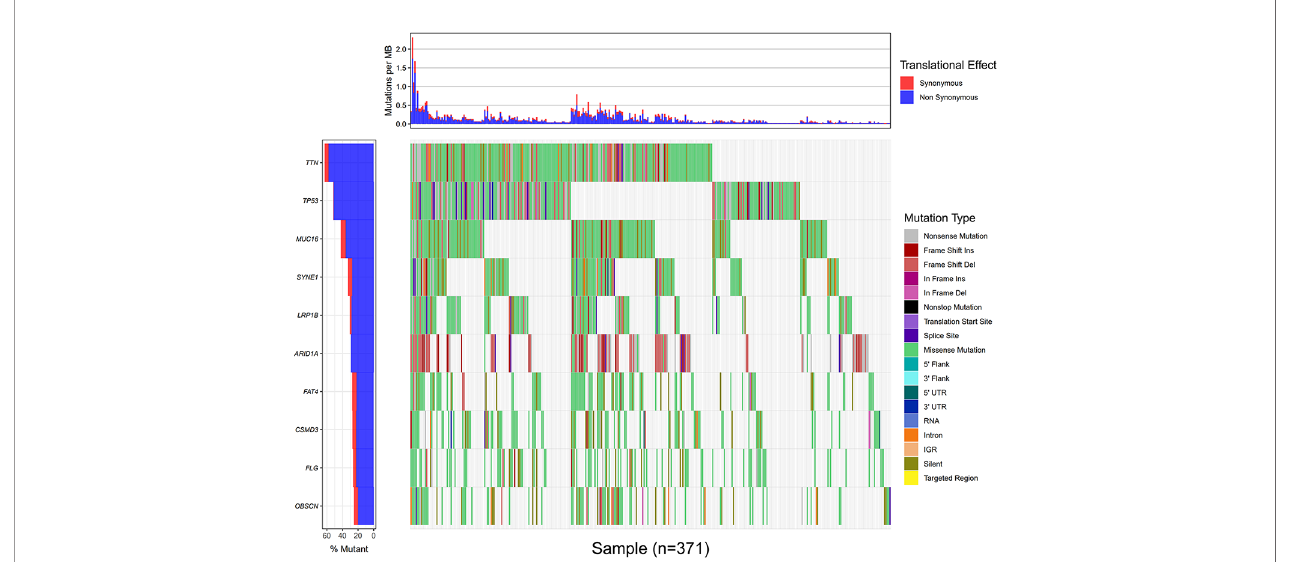
FIGURE 1 | Data processing and analysis. A waterfall map of 10 genes that were mutated in more than 90 samples.